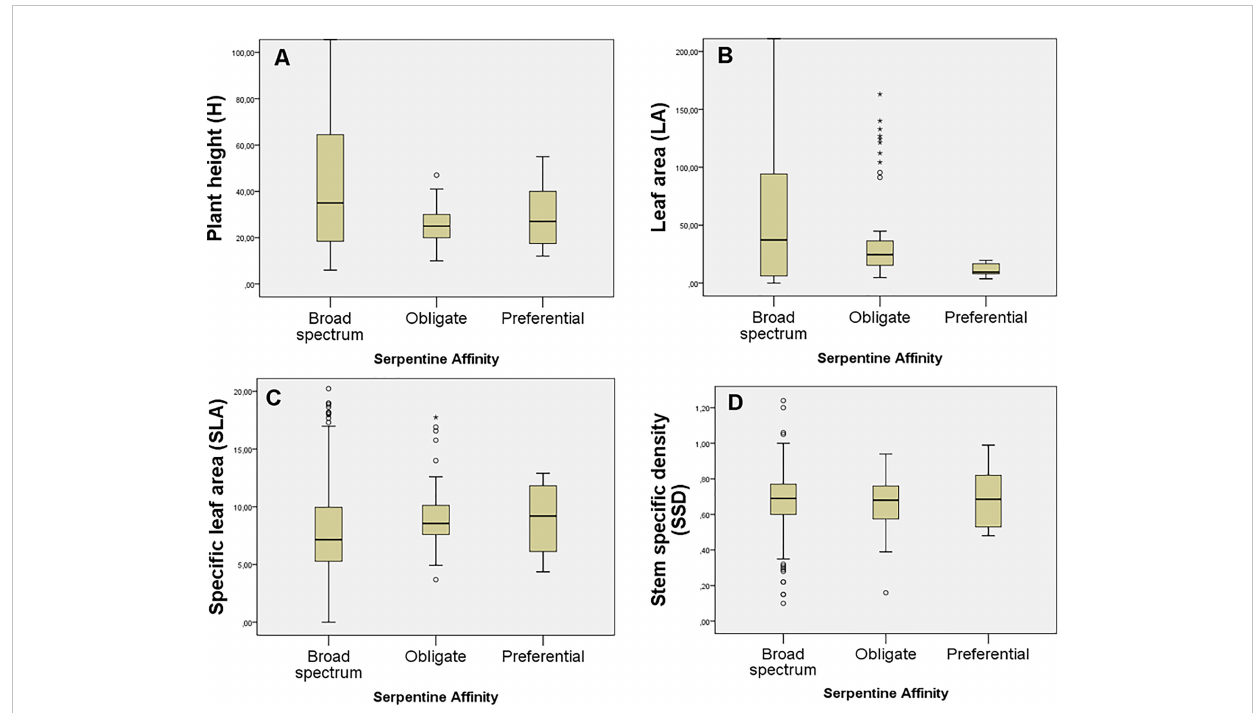
FIGURE 3 Mean trait values for: (A) H (plant height, cm), (B) LA (leaf area, mm 2 ), (C) SLA (speci fi c leaf area, mm 2 /mg), and (D) SSD (stem speci fi c density, mg/ mm³). The traits are grouped into the three serpentine af fi nity groups (O: Obligate; P: Preferential; and BS: